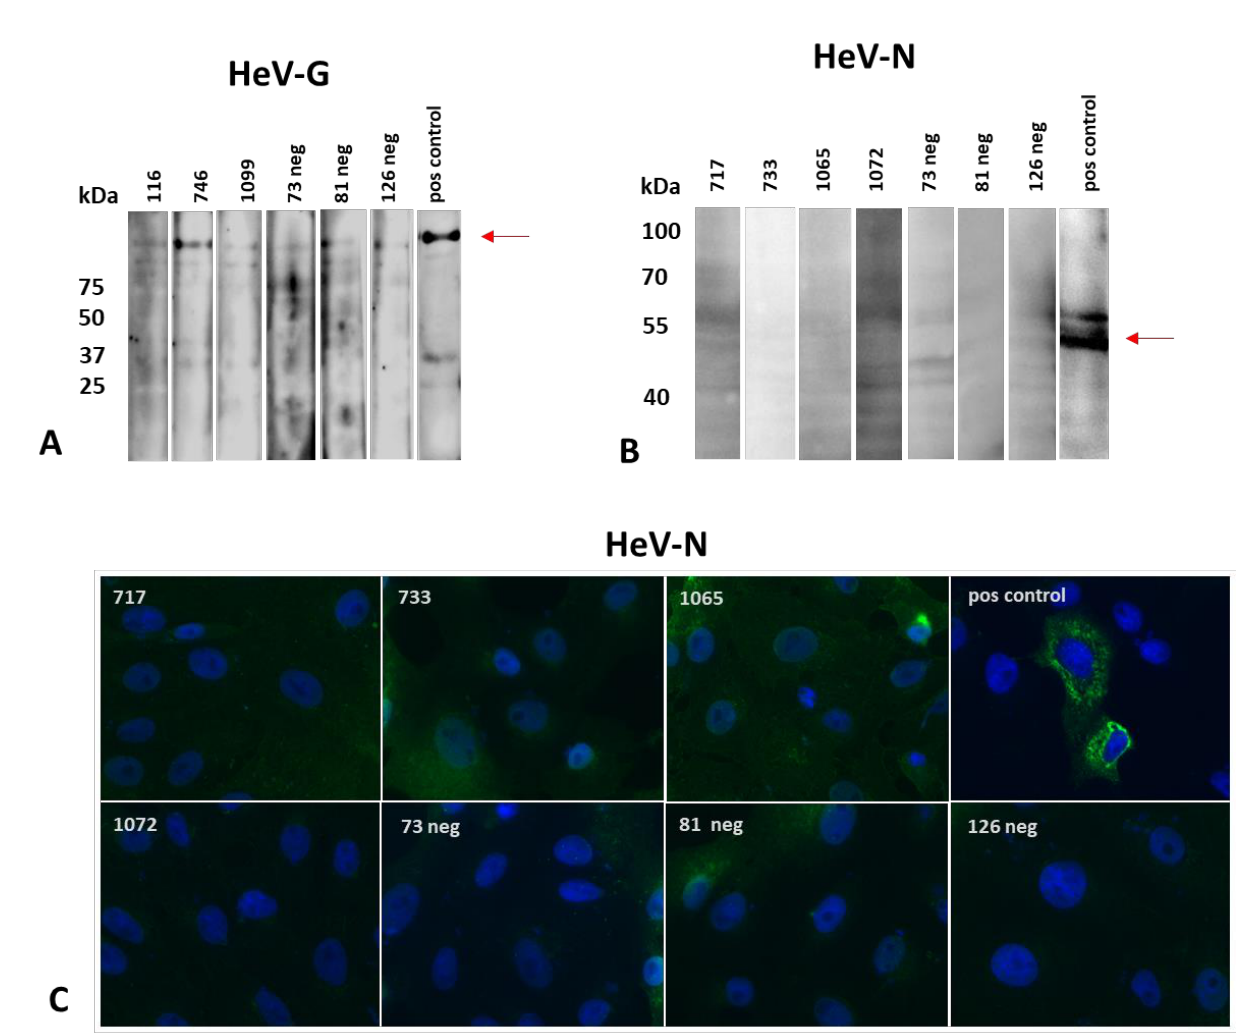
Figure 4. Re-testing of reactive sera by Western blot and IF analysis. ( A ) HeV-G reactive German horse sera numbers 116, 746, and 1099 as well as negative control sera numbers 126, 81, and 73 were tested by Western blot using a commercially available HeV-G expressed in HEK 293T cells as antigen. ( B ) HeV-N reactive German horse sera numbers 717, 733, 1065, and 1072 as well as negative control sera numbers 126, 81, and 73 were tested by Western blot using lysates of HEK 293T cells expressing HeV-N as antigen, ( C ) as well as by IF analysis using Vero76 cells transiently expressing HeV-N. Red arrows indicate expected molecular masses of HeV-G and HeV-N, respectively.